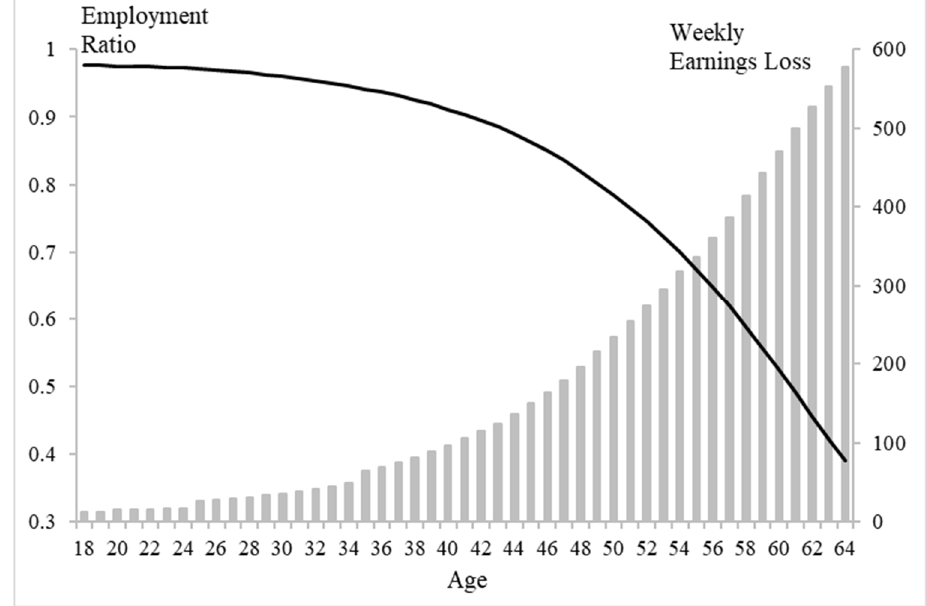
Figure 2. The weekly employment ratio of the group sick with COVID-19 relative to the healthy group and the weekly productivity loss for people aged from 18 to 64 years.